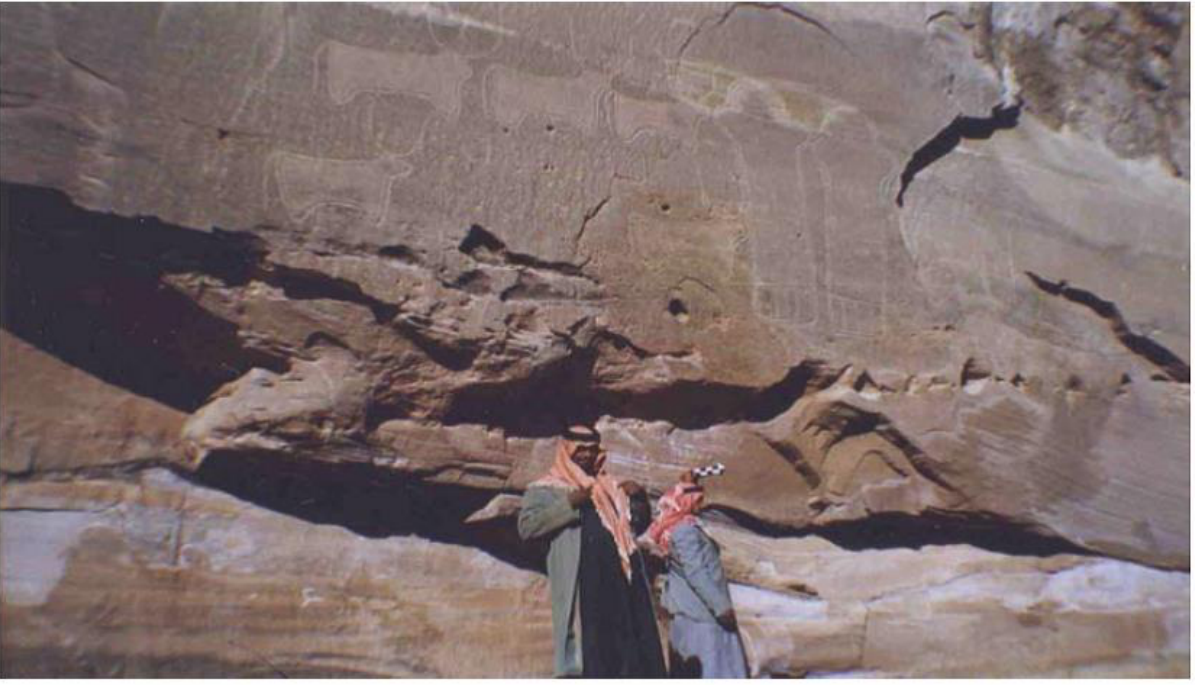
Figure 12. In Wadi Damm, northwest of Tabuk, this composition of idoliform and bovid representations constitutes an open-air temple in the middle of the desert. Bulls were sacred animals, both in prehistoric Arabia and in Egypt [17,18]. The panel is located at about 5 m high on the smooth sandstone hill surface. High skill and advanced technology was used in creating this splendid and amazing work of art that still survived until now. The date of the rock art is